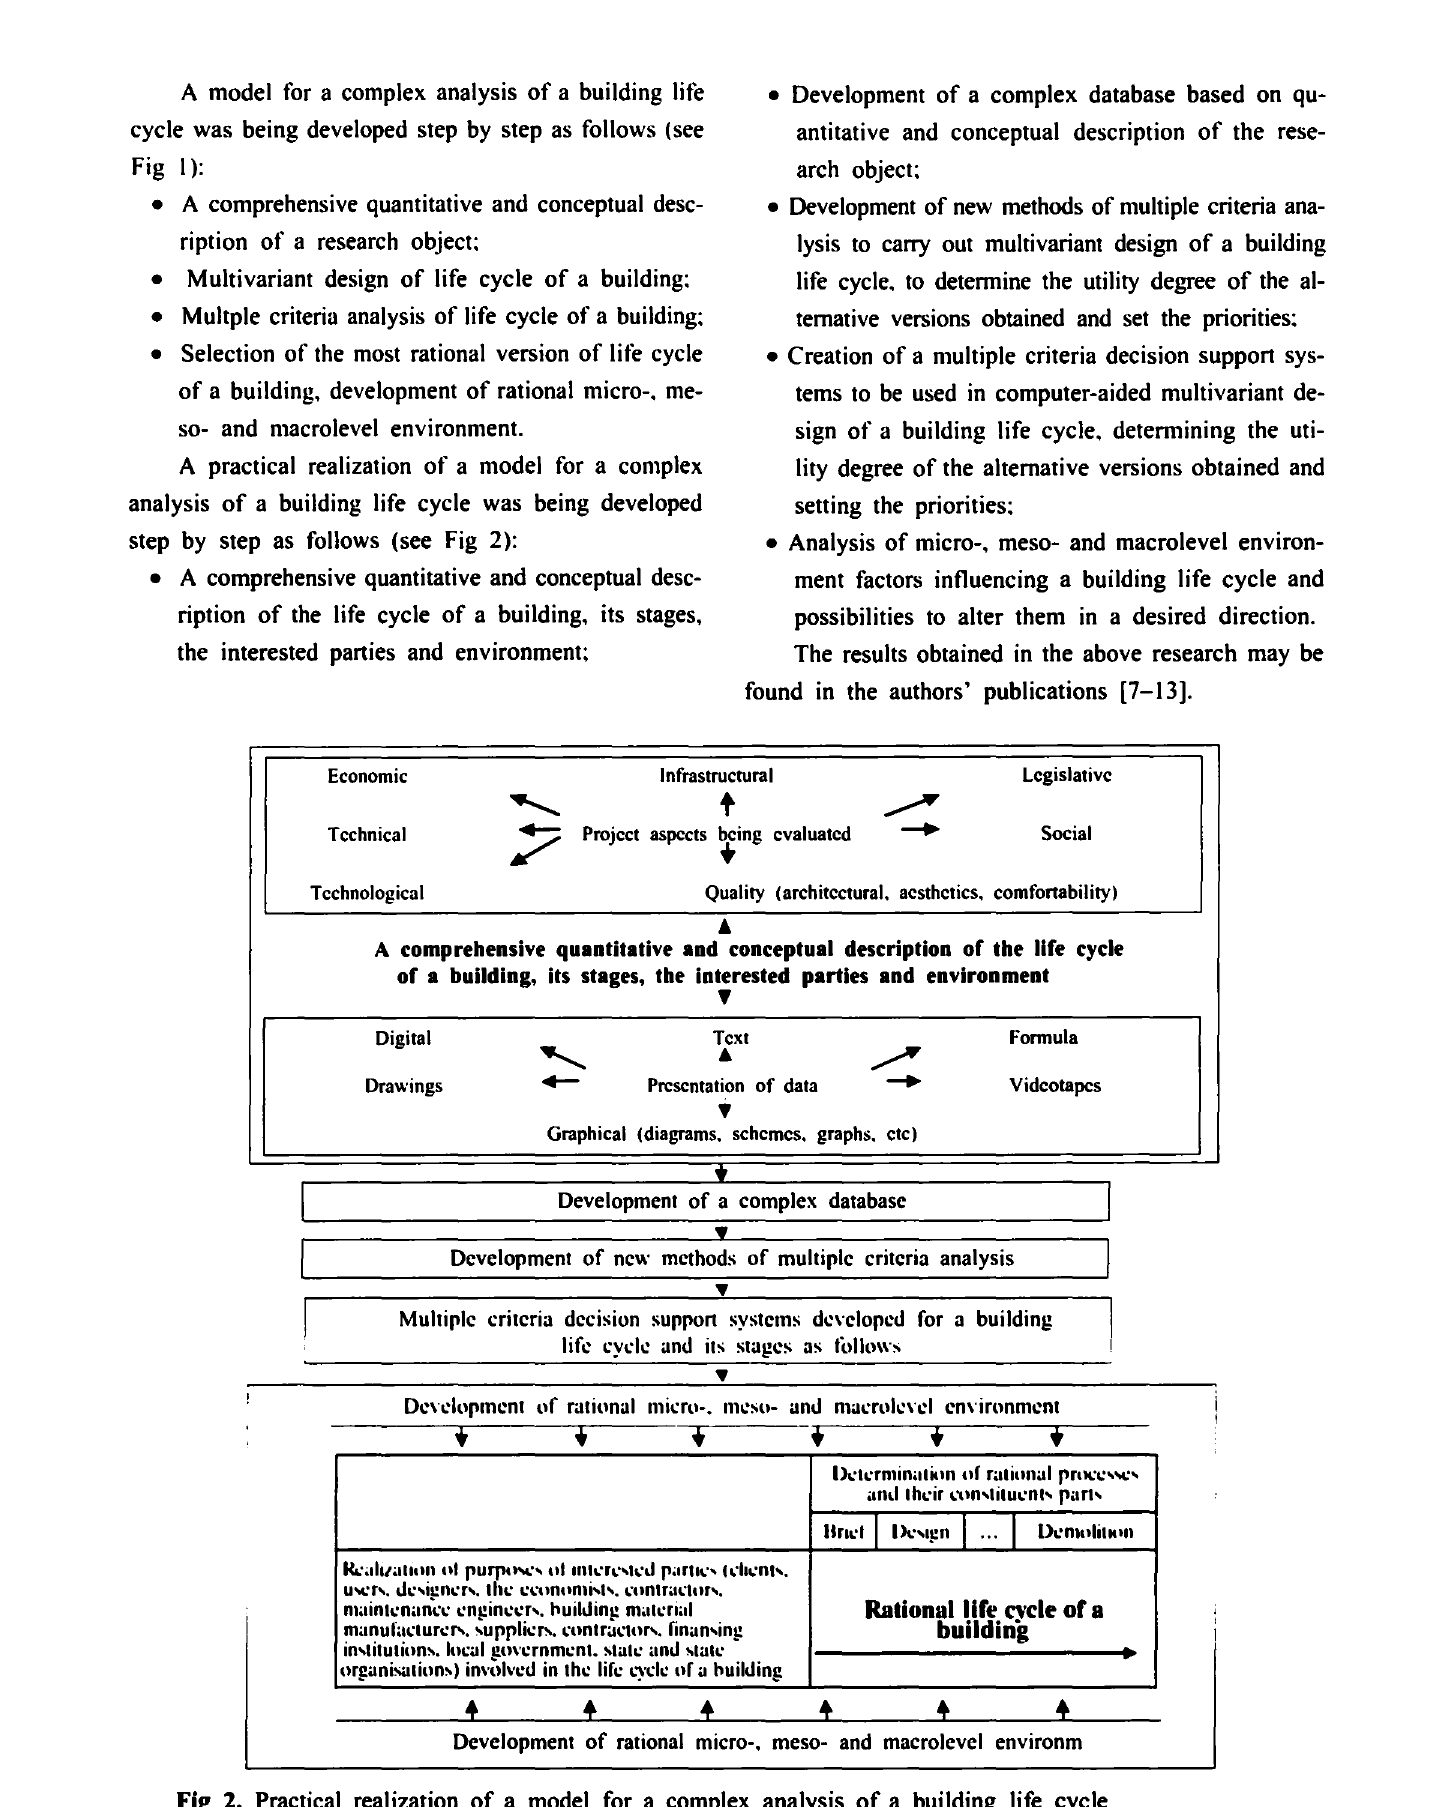
Fig 2. Practical realization of a model for a complex analysis of a building life